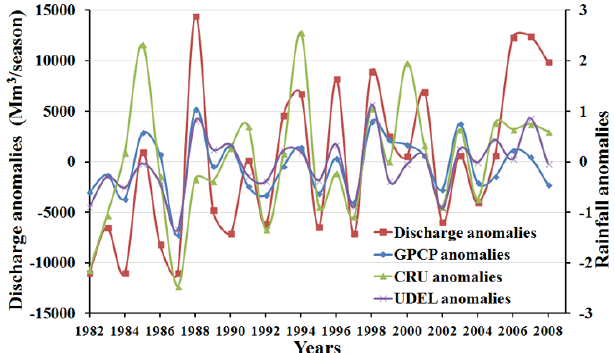
Table 5. The correlation between the discharge anomalies at Eldiem station and GPCP, CRU and UDEL rainfall anomalies and over the